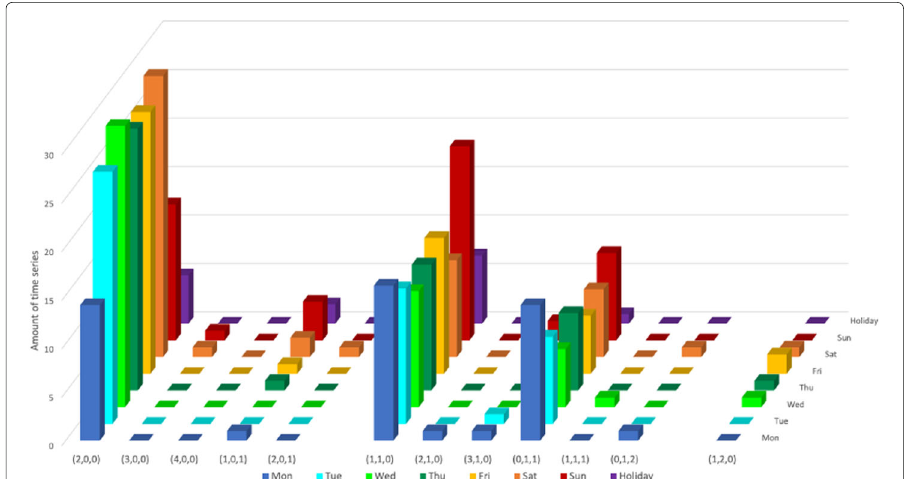
Fig. 8 Amount of time series per cluster (mAIC) per